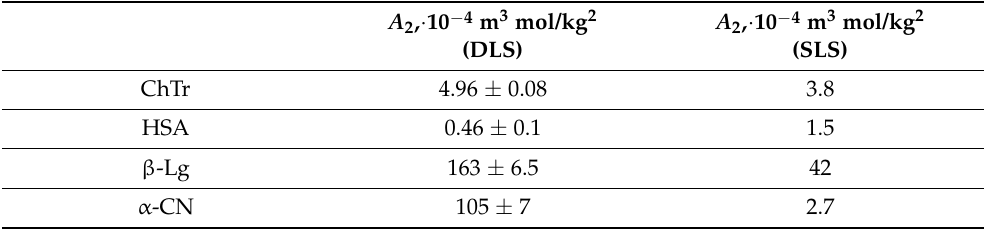
Table 1. Second virial coefficients of proteins obtained by the light scattering [51,73,79,120,128,130].